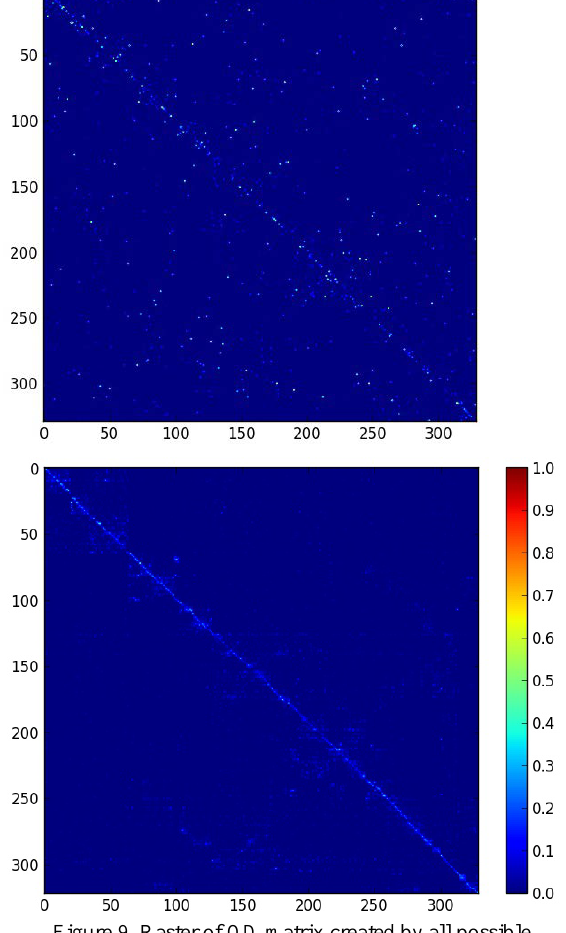
Figure 9. Raster of OD matrix created by all possible combination of model’s attributes (top) and the one created by survey based travel data